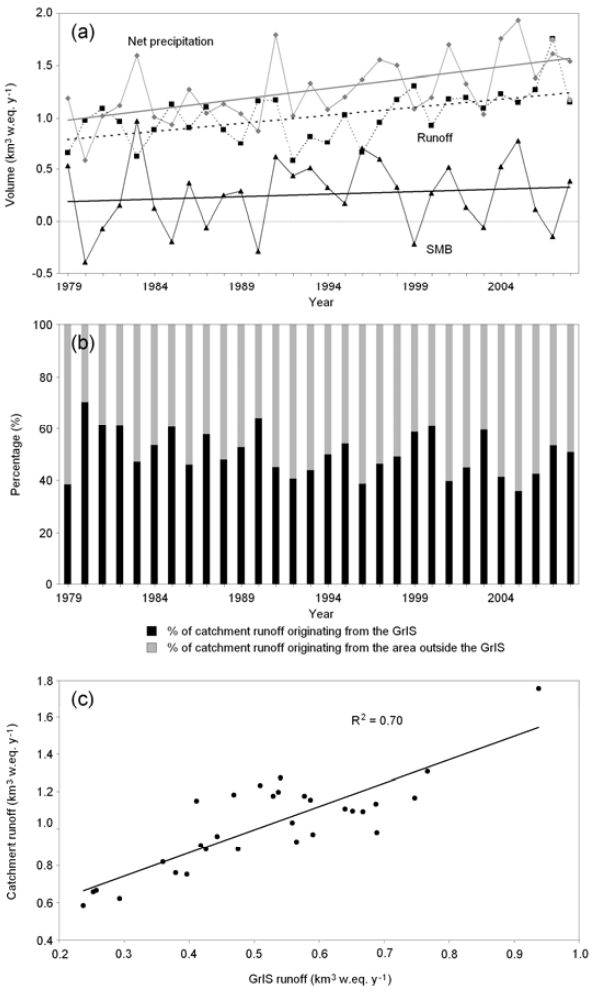
Fig. 3. (a) Kangerlussuaq net precipitation, runoff, and change in storage ( Δ S; SMB) series for 1978/1979 through 2007/2008. For 2007 and 2008, the observed June through August runoff is further illustrated based on data from Mernild et al. (2009); (b) percentage of catchment runoff originating from the GrIS and the proglacier landscape (to get the runoff contribution from the proglacier landscape, the GrIS runoff was subtracted from the overall catchment runoff); and (c) relationship between GrIS runoff and Kangerlussuaq catchment runoff.